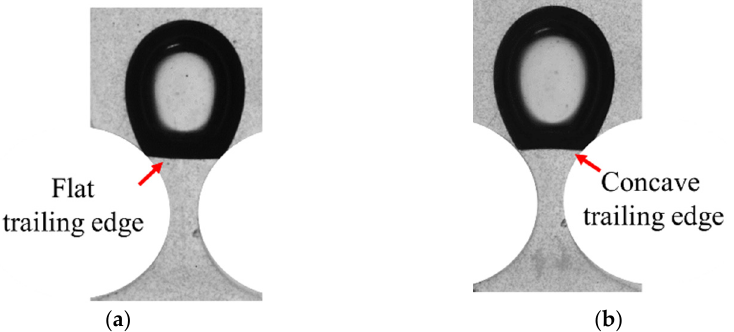
Figure 7. Pinning of a bubble existing a smooth pore interface at ( a ) 0.1 mL/min and ( b ) 0.3